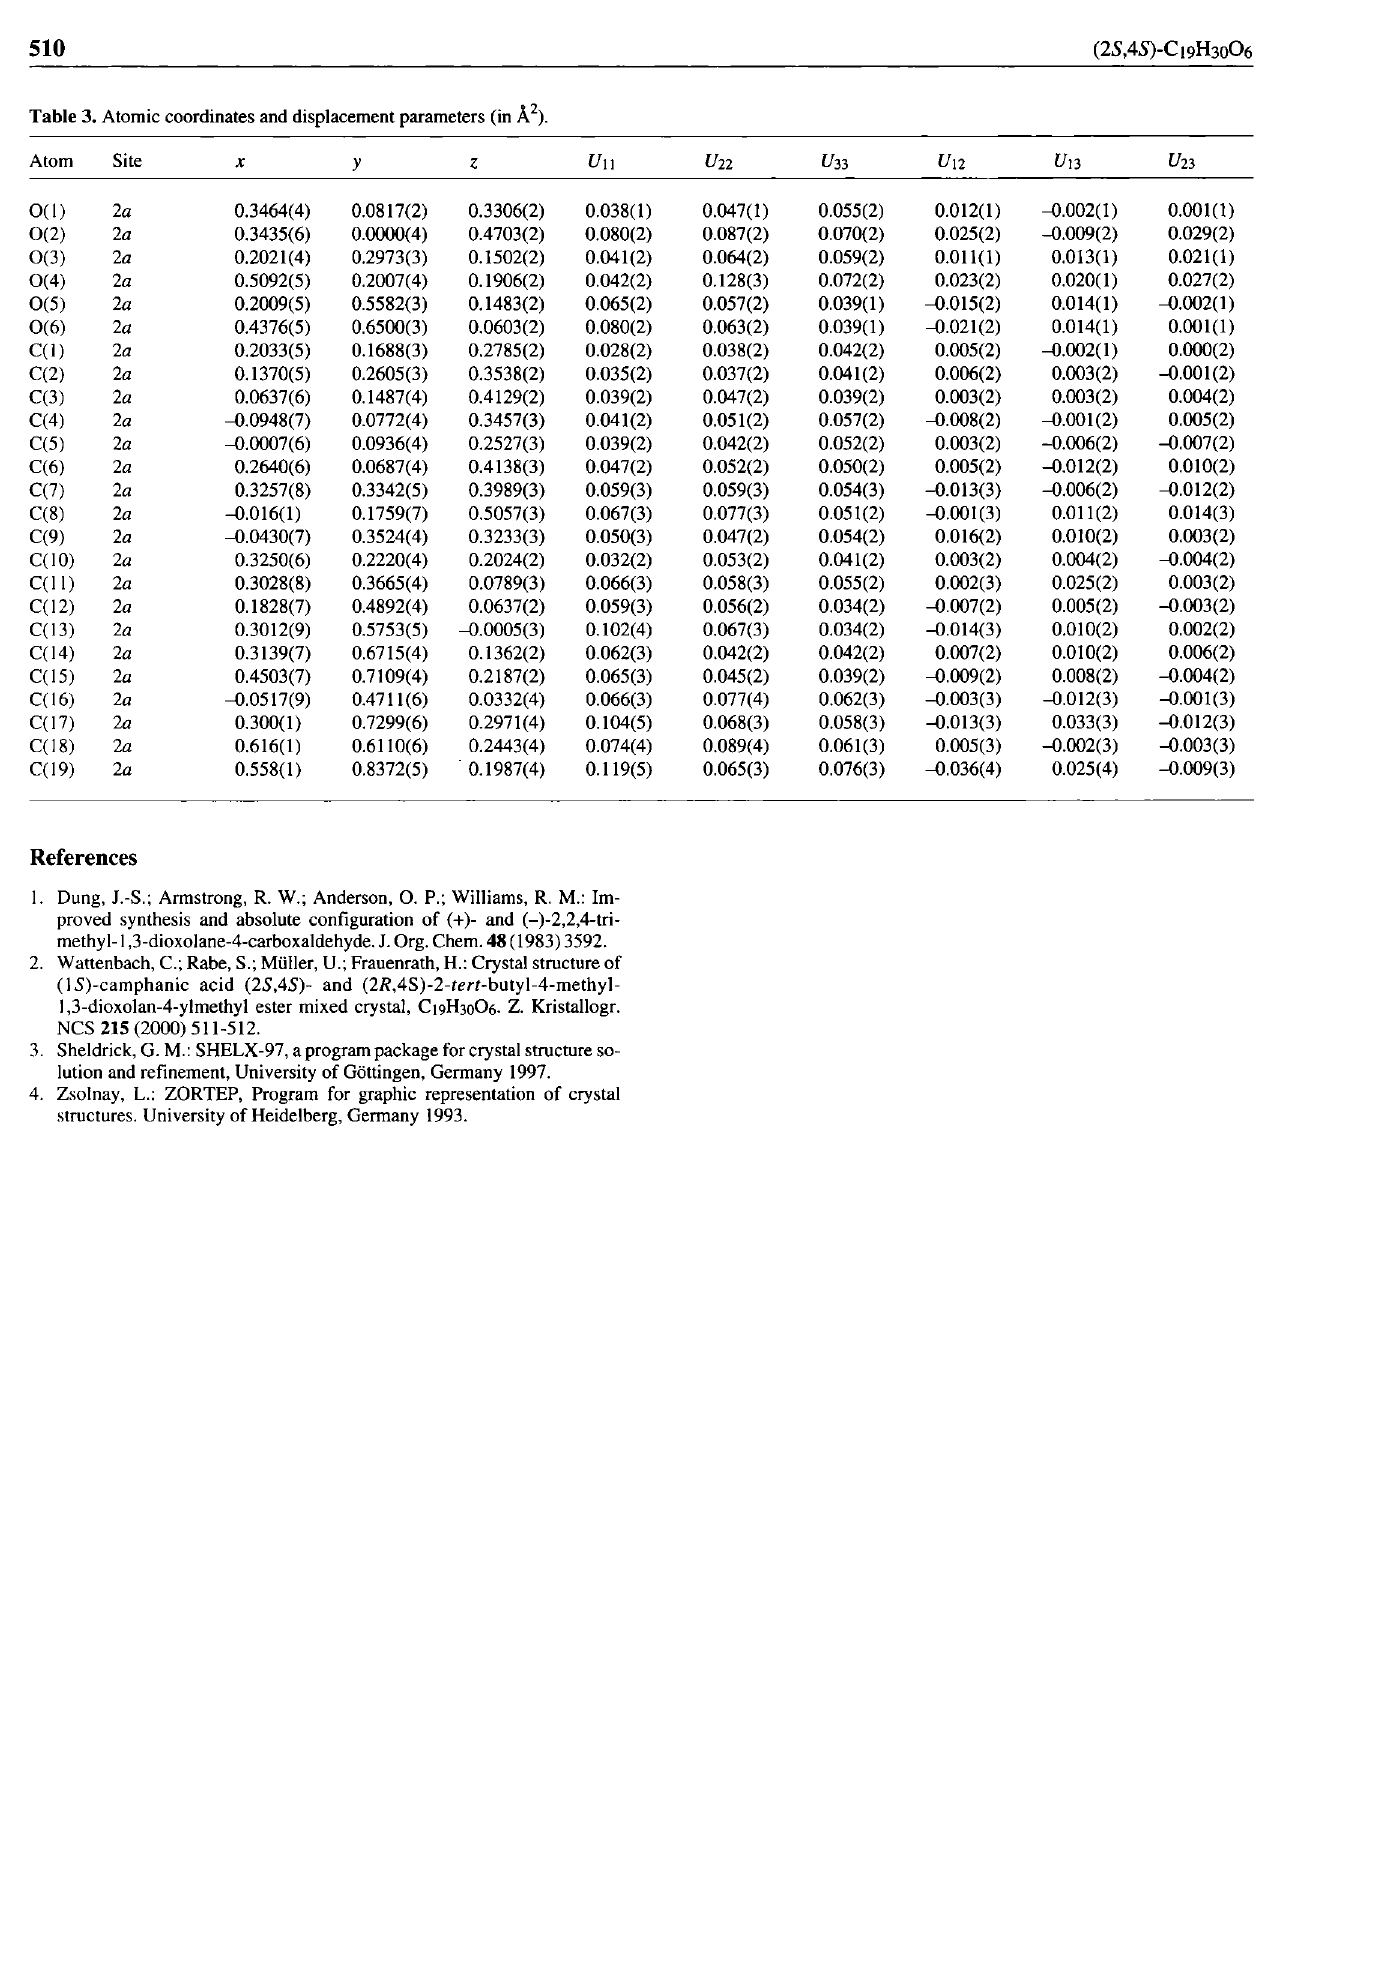
Table 3. Atomic coordinates and displacement parameters (in Â 2